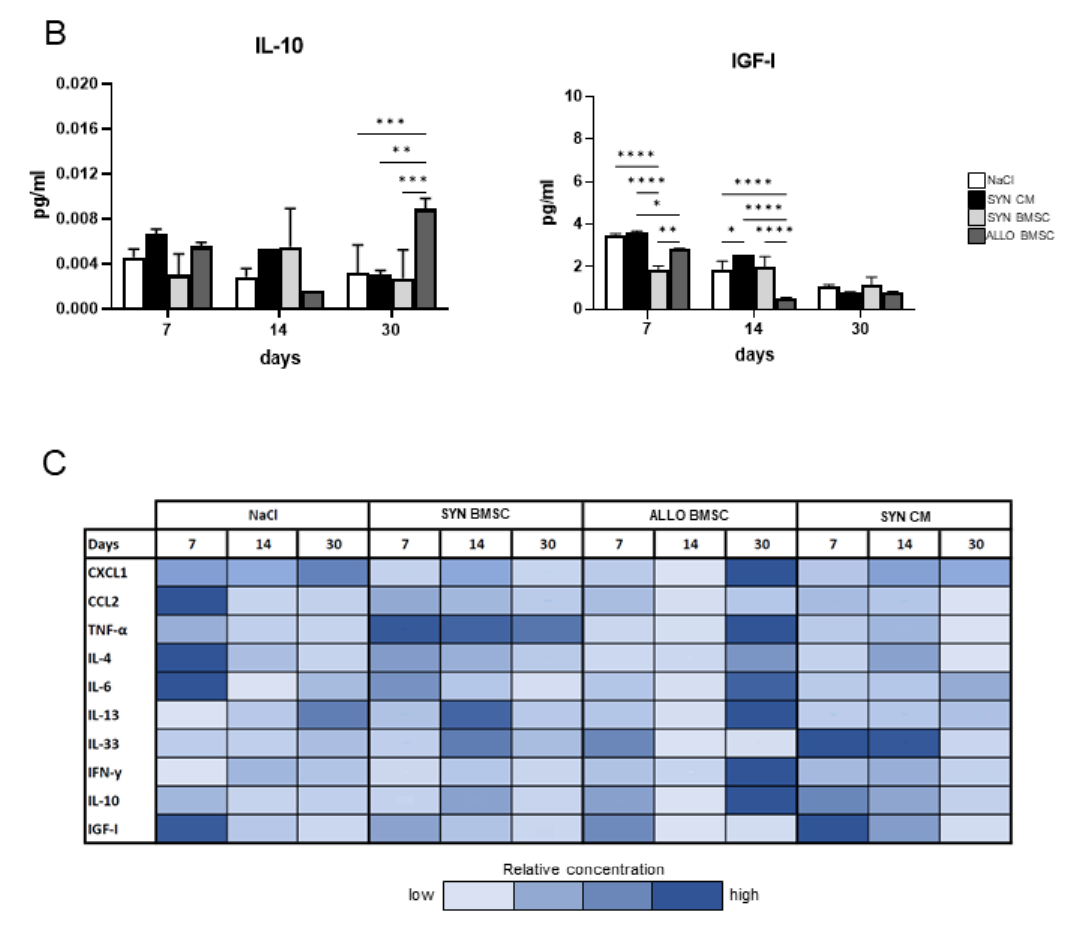
Figure 5. Luminex assay analysis of regenerating muscles injected with NaCl or SYN CM or SYN or ALLO BMSCs. ( A ) Concentration of pro-inflammatory factors: CXCL1, CCL2, TNF- α , IL-4, IL-6, IL-13, IL-33, and IFN- γ in muscles injected with NaCl (control, white bars) or SYN CM (black bars) or SYN BMSCs (light grey bars) or ALLO BMSCs (dark grey bars) on days 7, 14, and 30 after injury. ( B ) Concentration of anti-inflammatory factors: IL-10 and IGF-I in muscles injected with NaCl (control, white bars) or SYN CM (black bars) or SYN BMSCs (light grey bars) or ALLO BMSCs (dark grey bars) on days 7, 14, and 30 after injury. Data are presented as means of three independent experiments with standard deviations. ( C ) Graphical summary of the Luminex assay analysis. The darker hue represents a higher relative concentration for each factor compared to the sample in which the highest concentration was found. Data found to be statistically significant are underlined on graphs and are marked with asterisks (* p < 0.05; ** p < 0.01; *** p < 0.001; **** p < 0.0001).